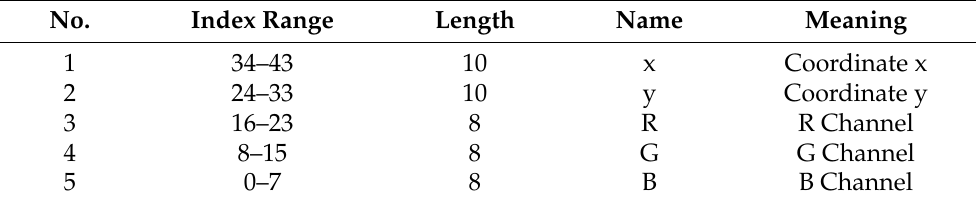
Table 1. Map table of the 44-bit binary